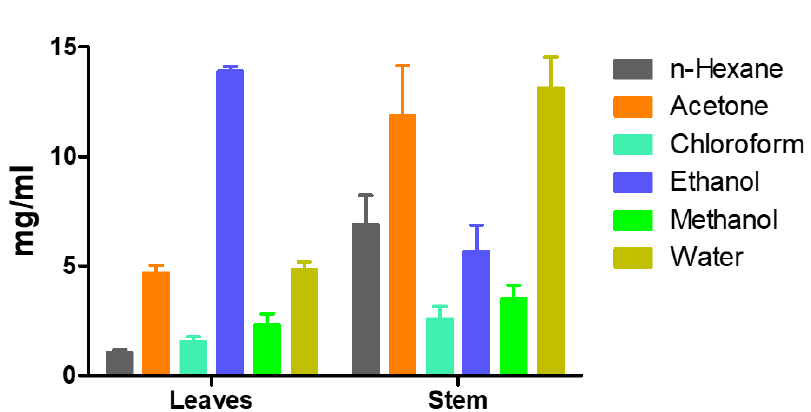
Figure 2. α -Amylase inhibitory activity of the di ff erent extracts tested: comparison of IC 50 values. The IC 50 values were calculated from dose-dependent percent inhibition. Values represent the means of triplicate measurements (n = 3). Bars represent the standard deviation. Table 2. Antioxidant activity of P . hydropiper extracts in di ff erent solvents at di ff erent concentrations. FRAP